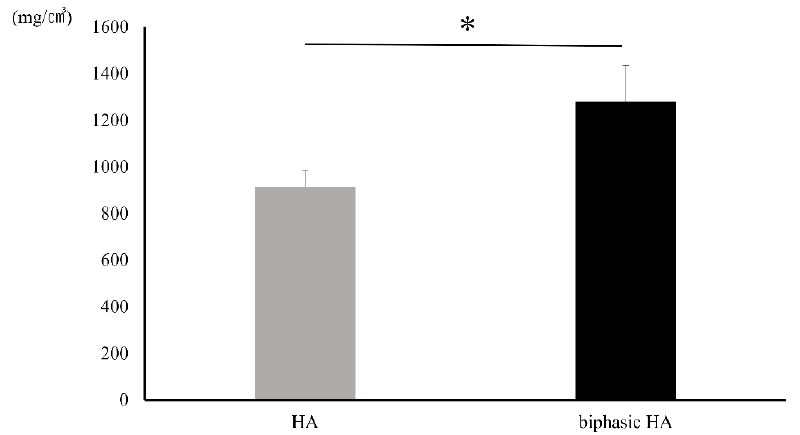
Figure 17. Area ratio of newly formed bone (n = 7, * p < 0.05).